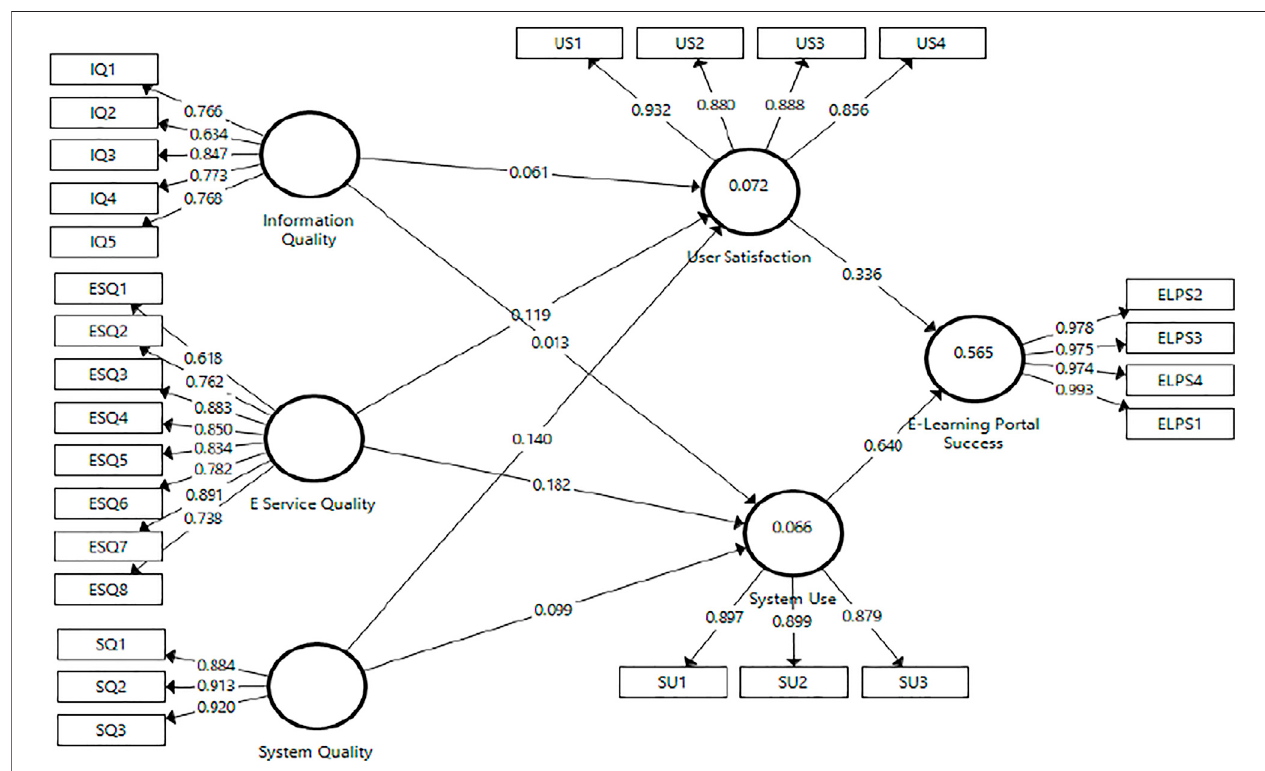
FIGURE 5 | Female measurement model.